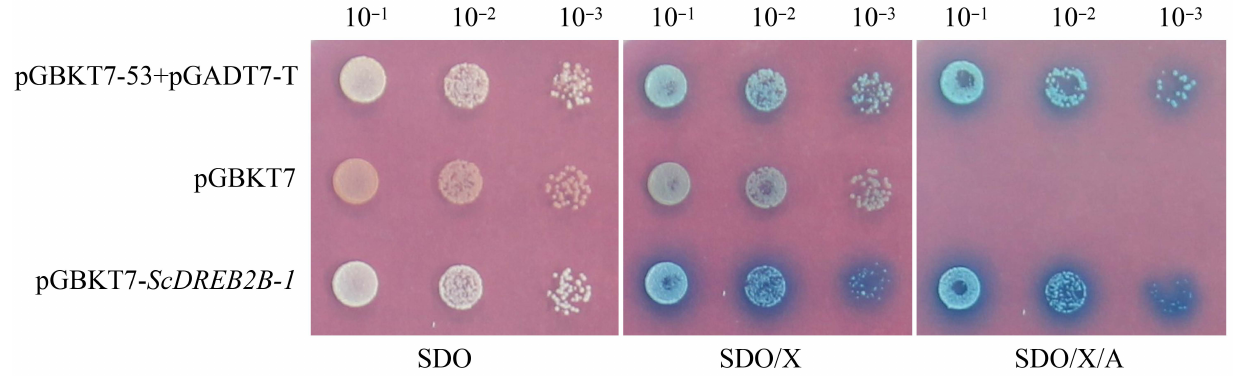
Figure 5. The transcriptional self-activation activity of ScDREB2B-1 protein in yeast. SDO: media without tryptophan; SDO/X: media without tryptophan but containing Trp/X- α -Gal dye; SDO/X/A: media without tryptophan but with Trp/X- α -Gal dye and aureobasidin A. pGBKT7-53+pGADT7-T: positive control; pGBKT7: negative control; pGBKT7- ScDREB2B-1 : yeast transformant with pGBKT7- ScDREB2B-1 .